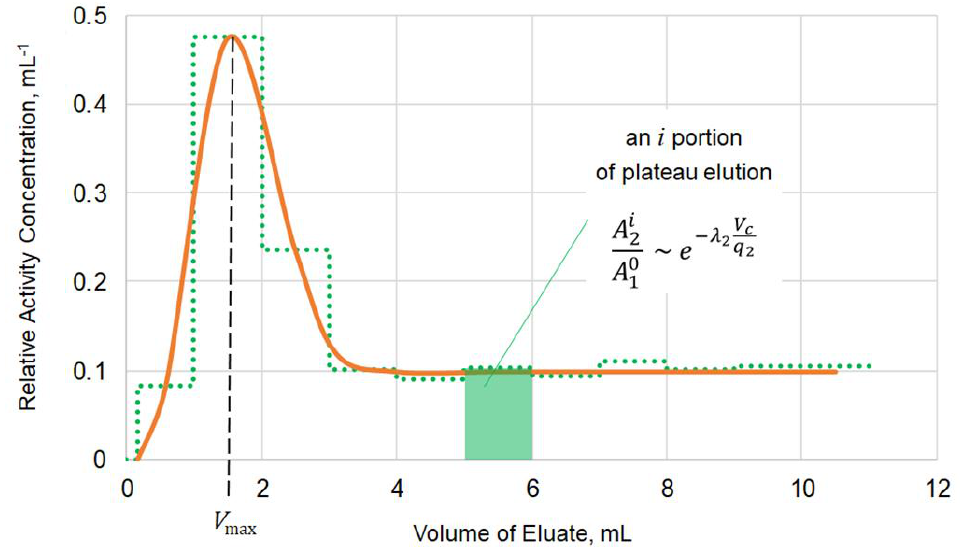
Figure 2. Differential (mL − 1 ) elution curve of 221 Fr eluted from the column containing 0.3 mL Actinide Resin with 0.0025 M NH 4 Cl solution passing at flow rate of 1.0 ± 0.1 mL/min. A dotted histogram and a solid curve represent experimental data and a fitting line, respectively. Designations: A i — 221 Fr activity in an i portion of plateau elution corrected for decay to the end of portion sampling; A 0 — 225 Ac activity at the start of elution; V c —residence time of 221 Fr in the chromatographic column (see explanation in the text below).